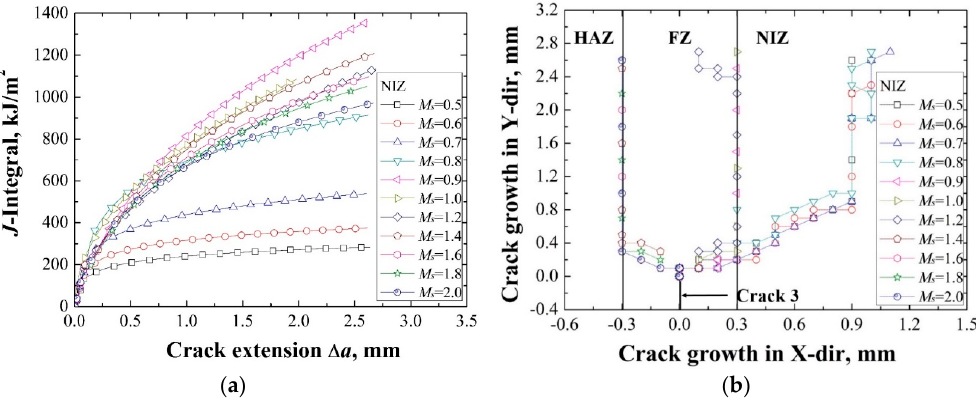
Figure 8. The J–R curves ( a ) and the crack growth paths ( b ) at different strengths of NIZ.